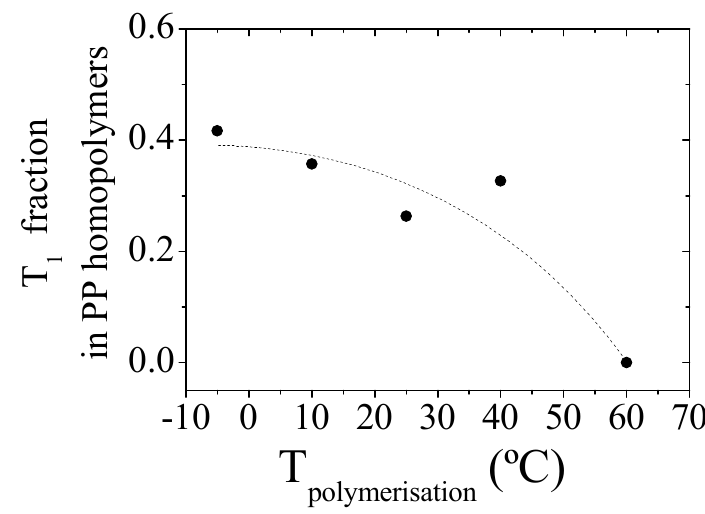
Figure 13. Evolution of T 1 content in PP samples with T pol .